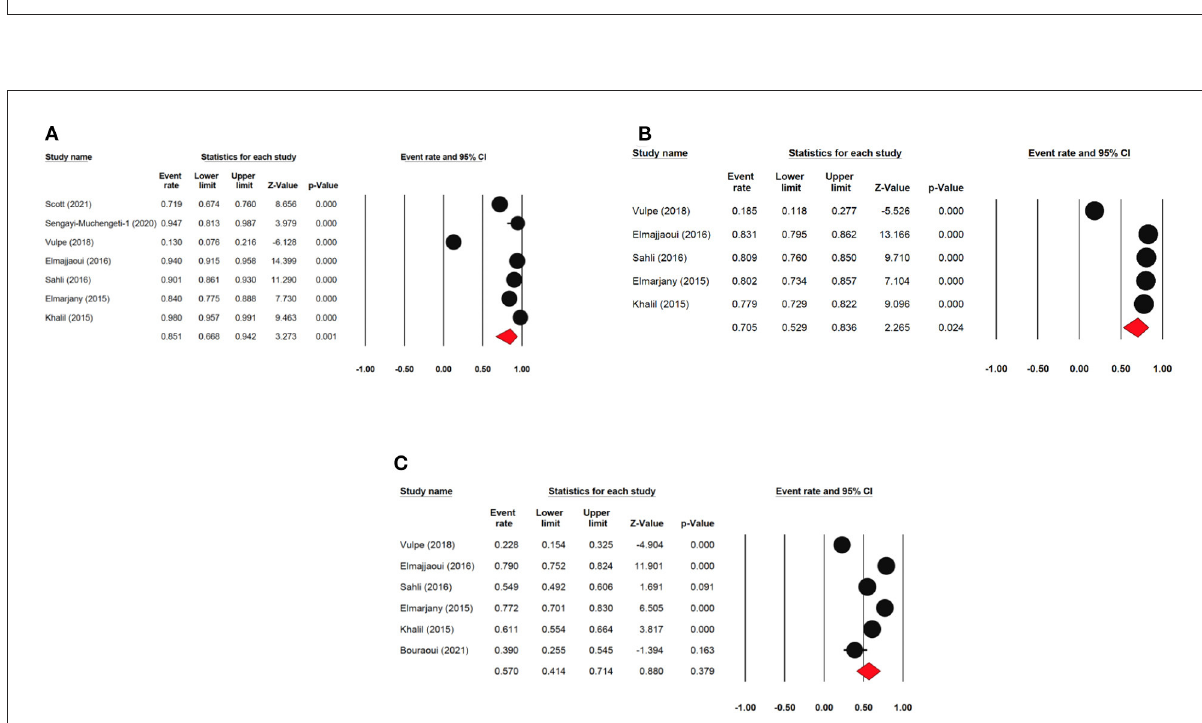
FIGURE4 Forest plot showing the DFS. (A) pooled 1-year DFS; (B) pooled 3-year DFS; (C) pooled 5-year DFS.